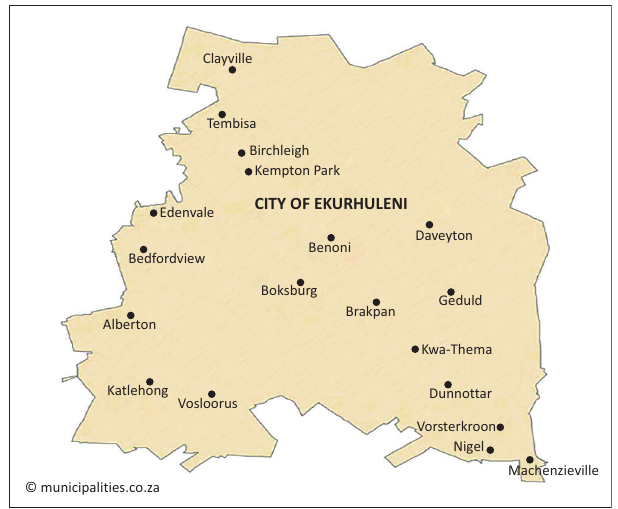
FIGURE 3 : Map of the City of Ekurhuleni Metropolitan